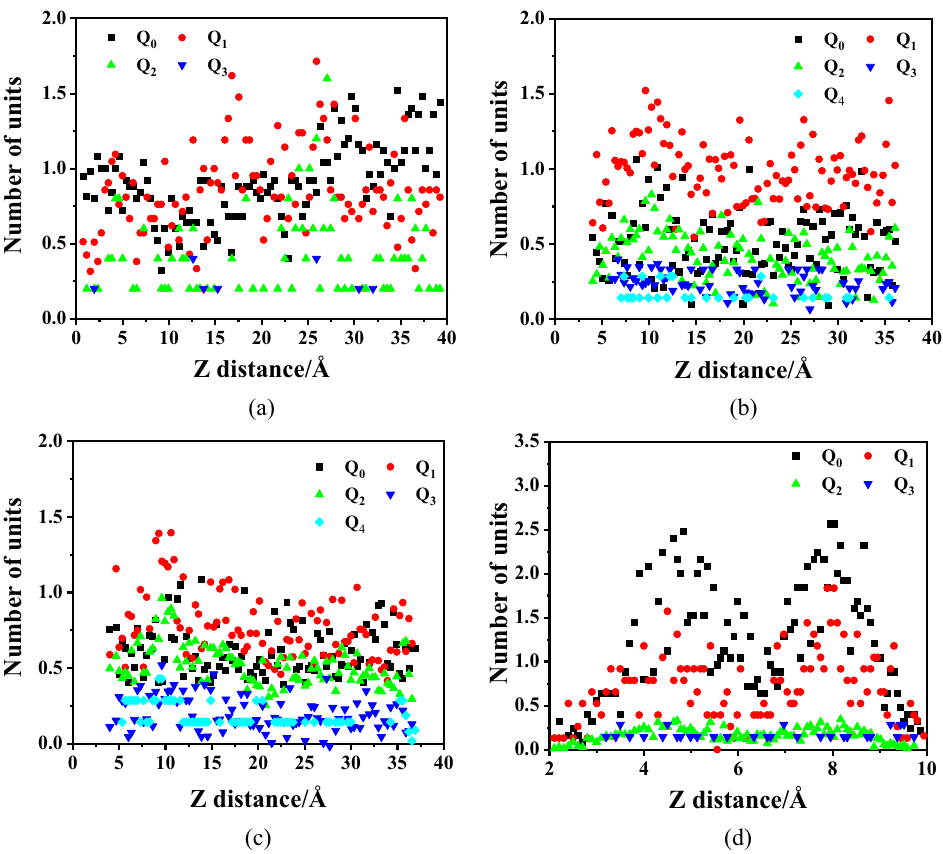
Figure 9: Q n element distribution in z direction. ( a ) Control, ( b ) GCOOH40 - 25, ( c ) GCOOH40 - 50, and ( d ) GCOOH10 -